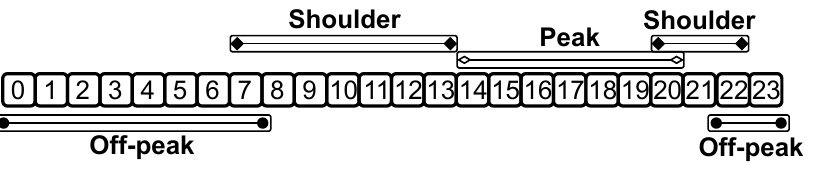
Figure 2. The volatile electricity categories per day stated by Energy Australia [28]. Each square presents a time of